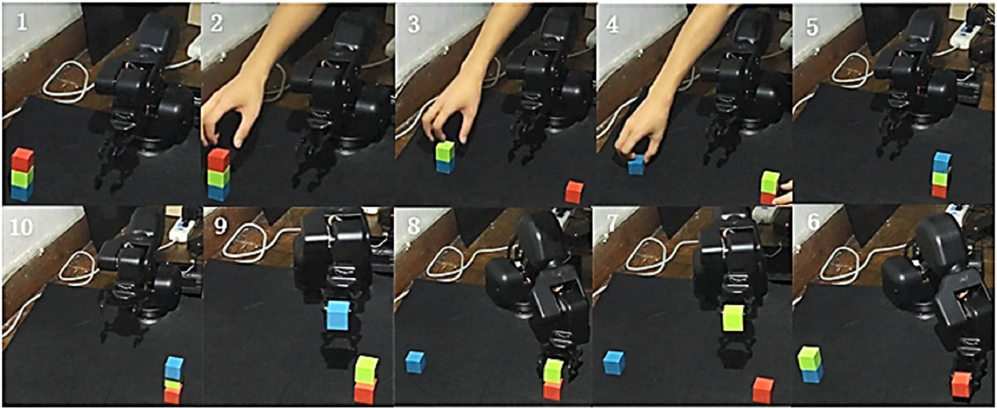
Figure 9. The whole imitation process of the manipulator in the experiments.